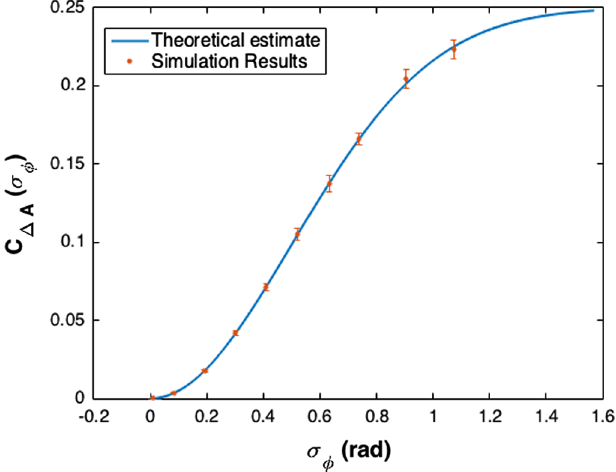
σ ϕ Þ , A ð FIG. 18. Damper correction factor as a function of α [Eq. (29)] for ρ sim